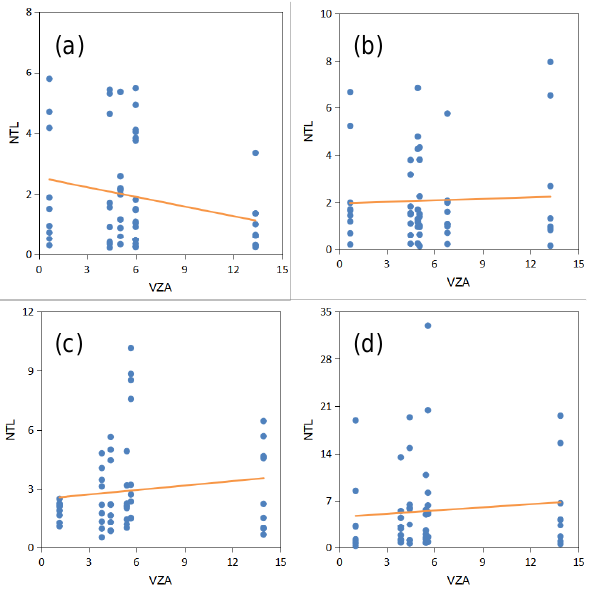
Figure 11. The nighttime light radiance changes (10 − 4 W/cm 2 /sr) along with the increase of satellite viewing zenith angle. The analysis results were derived from four AERONET station, including Beijing_PKU ( a ), Beijing_CAMS ( b ), Beijing_RADI ( c ), and Beijing station ( d ).The solid orange line is the regression line.